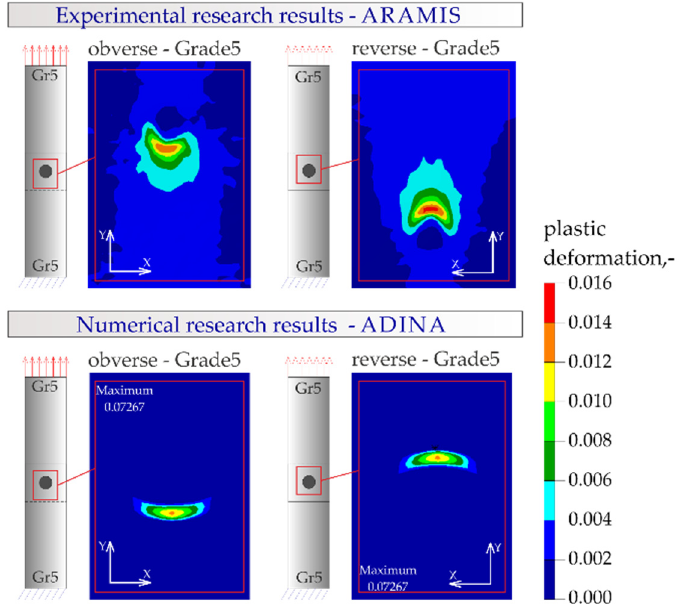
Figure 25. Distribution of plastic deformations in the joints with a single weld—Gr5–Gr5.1. In all the Gr2–Gr5 and Gr5–Gr5 joints analyzed, similar distributions of plastic defor- mations were obtained using both test methods. The value of deformation obtained from the experimental tests corresponded to the values obtained in the numerical